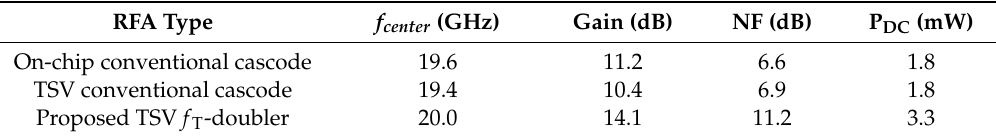
Table 1. Performance Summary.